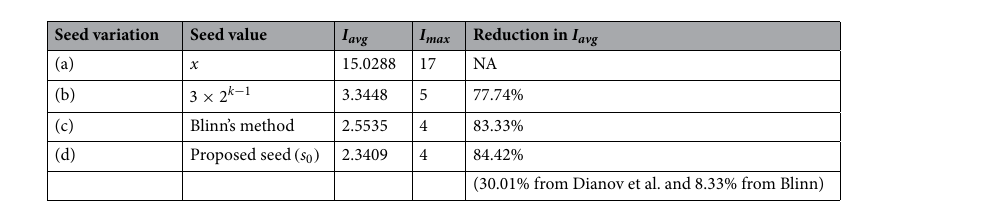
k − 1 . ( c ) Seed using Blinn’s method. ( d ) Seed is obtained using our